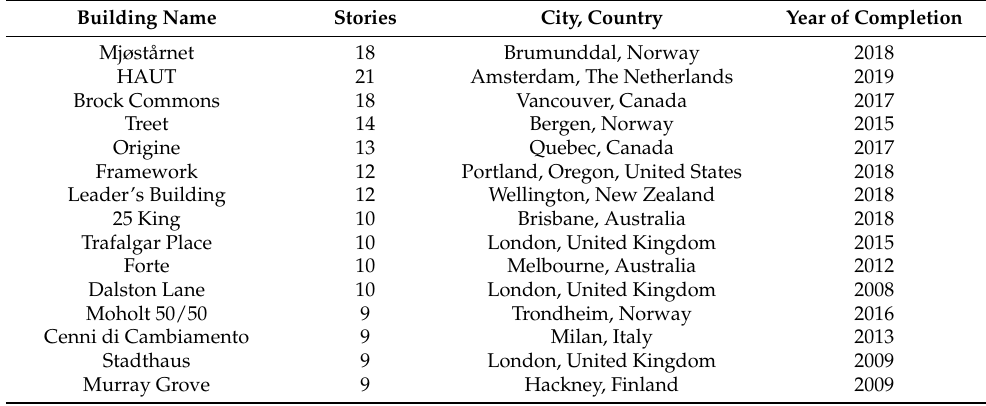
Table 1. List of current multi-storey timber